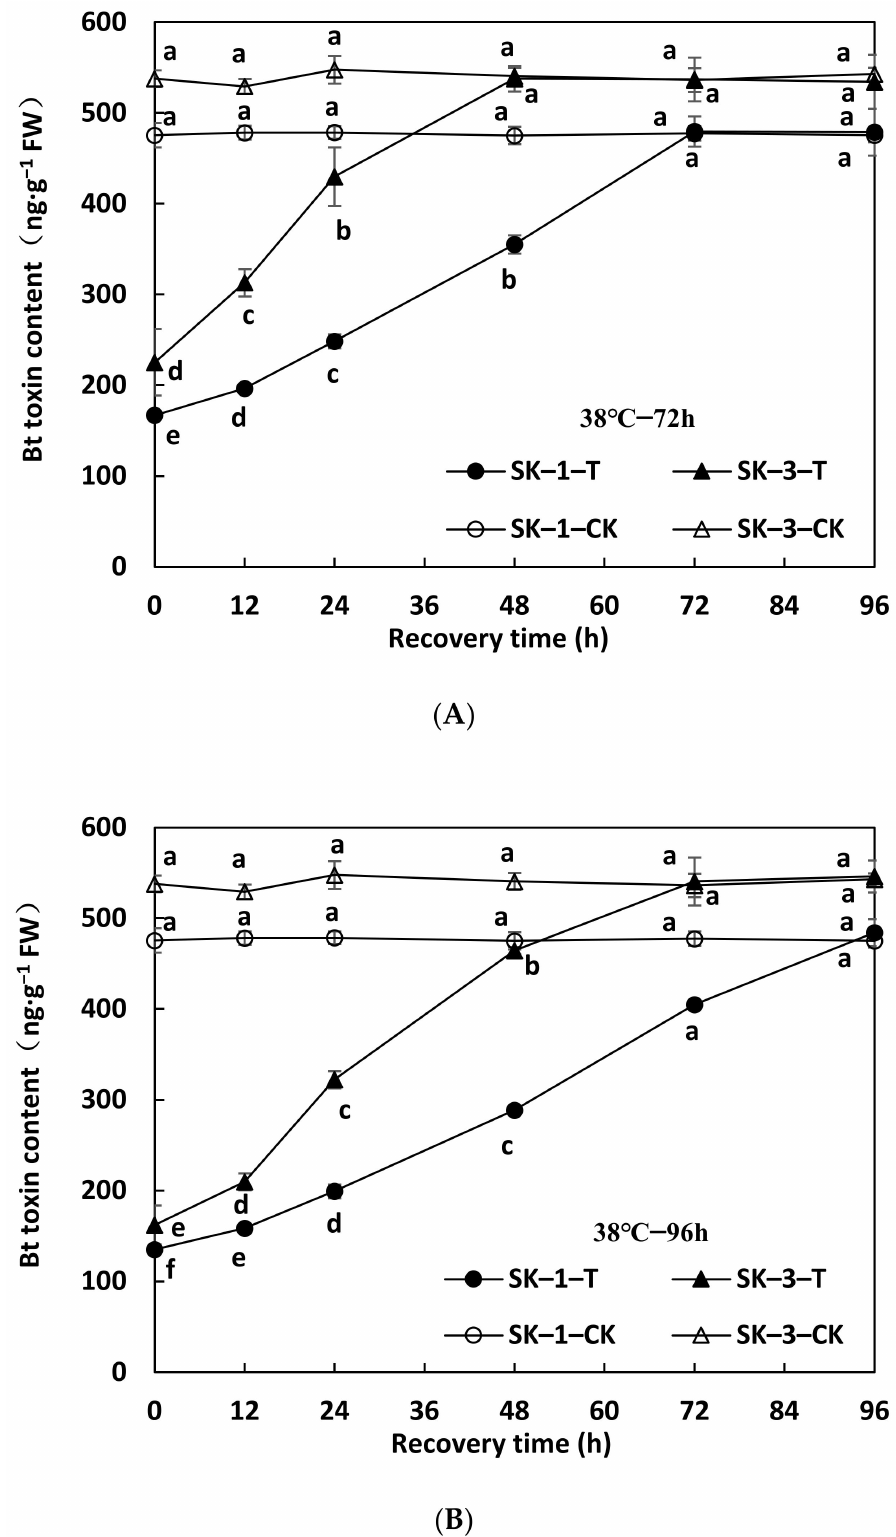
Figure 1. Changes of insecticidal protein content in squares of Bt cotton after 72 h ( A ) and 96 h ( B ) high-temperature stress termination. Bt toxin content at the recovery time with different lowercase letters is significantly different from the control at p < 0.05 under the same high-temperature stress duration for the same cultivar. T—treatments for 72 h ( A ) and 96 h ( B );